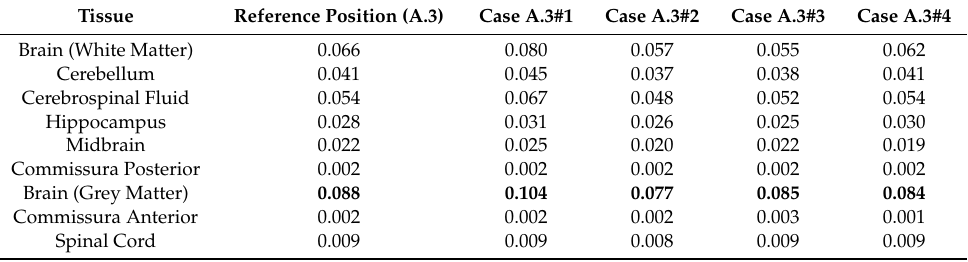
Table 4. Maximum values of E-field (V / m) for the CNS tissues. Influence of body position for posture A.3.